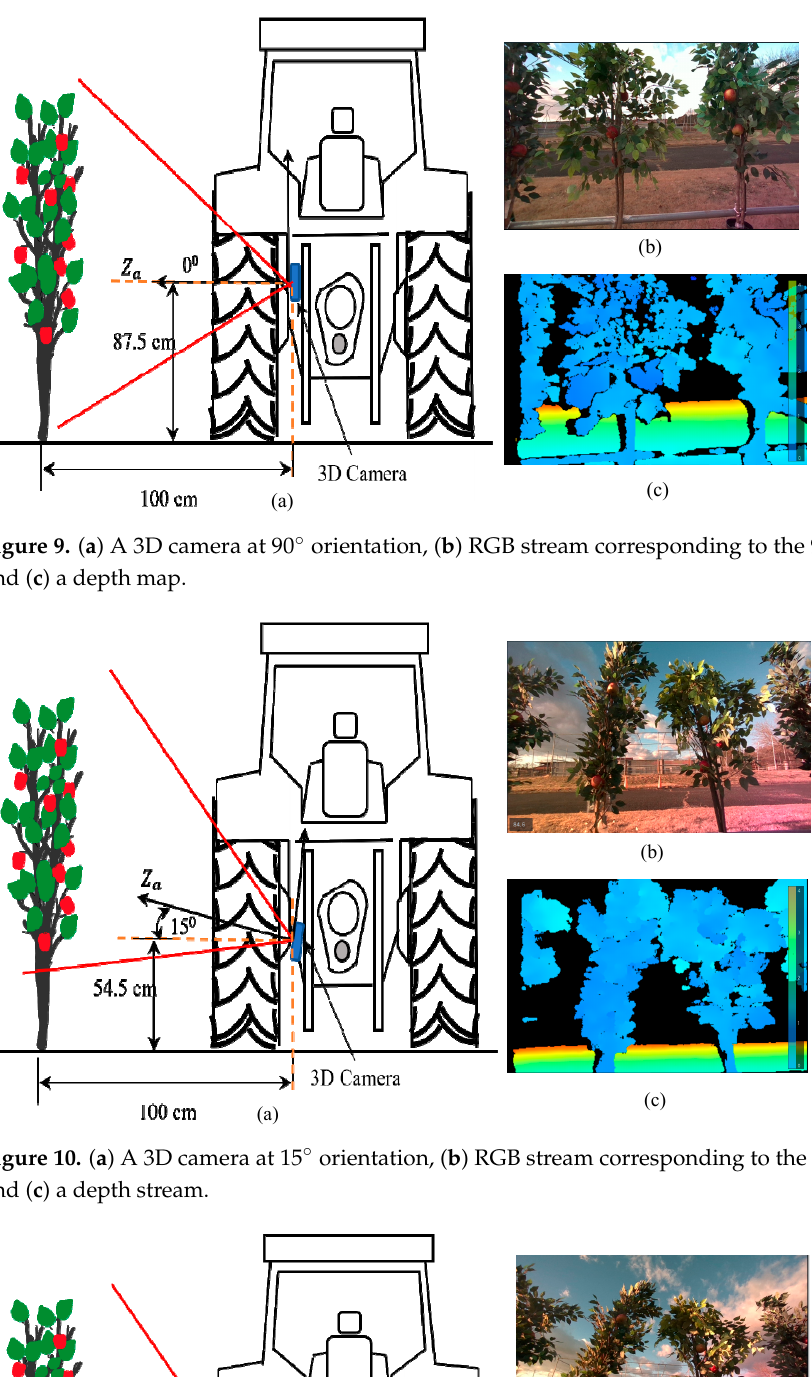
Figure 12. Outdoor experiments using a four ‐ wheel tractor and artificial trees to create a specially designed orchard. 3.7. Experimental Evaluation Once the apple was detected using deep learning algorithms, the detected apple was tracked until the apple was away from the camera frame. In the operation of har ‐ vesting and yield estimation, this step was essential. Without it, the single detected ap ‐ ple in the first frame could have been counted every time the frame changed. Simple online real ‐ time tracking (SORT) is a method of multiple object tracking (MOT) based on spatial and temporal features. Once the object detection algorithm detected the apples in the frame, the estimation of the same apple in the next frame was performed by a con ‐ stant velocity model via the Kalman filter framework. In data association, the Hungarian algorithm was used to check the IoU of the detection based on a threshold value. In the IoU threshold, the value was set to 50%. In this study, we applied the Deep SORT algo ‐ rithm for tracking tasks. As an extension of the SORT algorithm, Deep SORT can be ap ‐ plied in CNNs [38]. In addition to the Kalman filter and Hungarian algorithms men ‐ tioned before, Deep SORT was applied for the prediction of bunding boxes to extract the localization patterns, meaning that, once the object of interest was localized under a pre ‐ defined confidence, the localization coordinates were loaded into the CNN embedded in the algorithm source. This technique helps in tracking the apples and maintaining their unique IDs by avoiding occlusion and repetition of IDs among the frames ( Figure 13 ). We used MobileNetV2 as a CNN in the Deep SORT algorithm to track the localization of